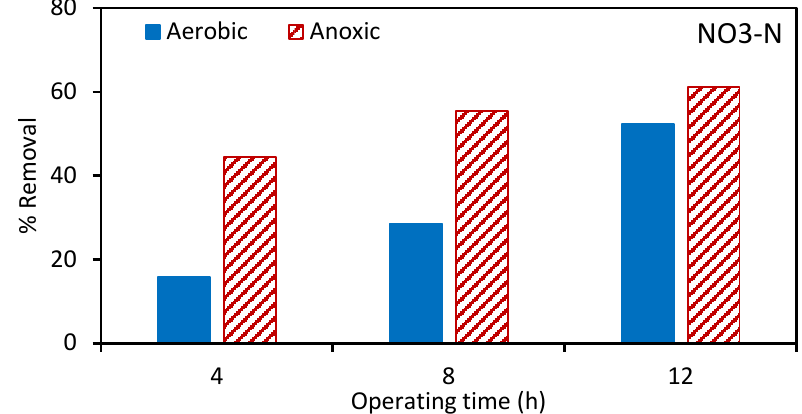
Figure 3. Percentage removal of total ammonia nitrogen (TAN) in the aerobic and anoxic tanks at 4, 8, and 12 h after spiking with atrazine. The total suspended solids (TSS) for the aerobic and anoxic tanks was 7029 and 6024 ± 600 mg/L, respectively.